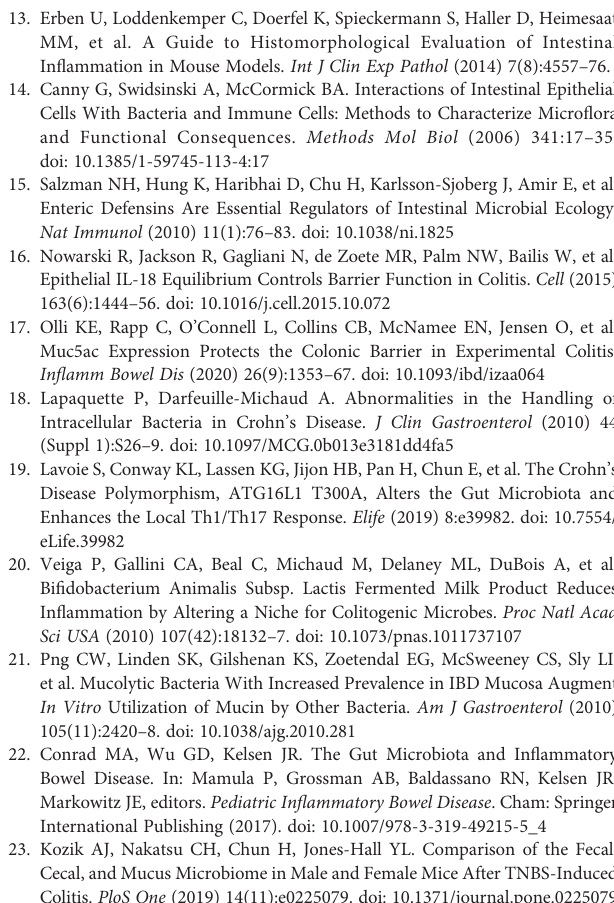
Supplementary Figure 1 | (A) Beta-diversity of colonic mucosa microbiota pro fi les of WT and Atg16L1 T300A/T300A mice samples illustrated with PCoA using unweighted UniFrac distance metrics. Samples colored by different group: WT (green, n = 8); Atg16L1 T300A/T300A (red, n = 7). The proportions of bacterial taxa in the colon (B) and ileum (C) mucosa were signi fi cantly differentially represented in WT mice vs. Atg16L1 T300A/T300A mice. Statistically signi fi cant differences were then evaluated by Tukey or Wilcoxon rank-sum post hoc tests.*p < 0.05, **p <